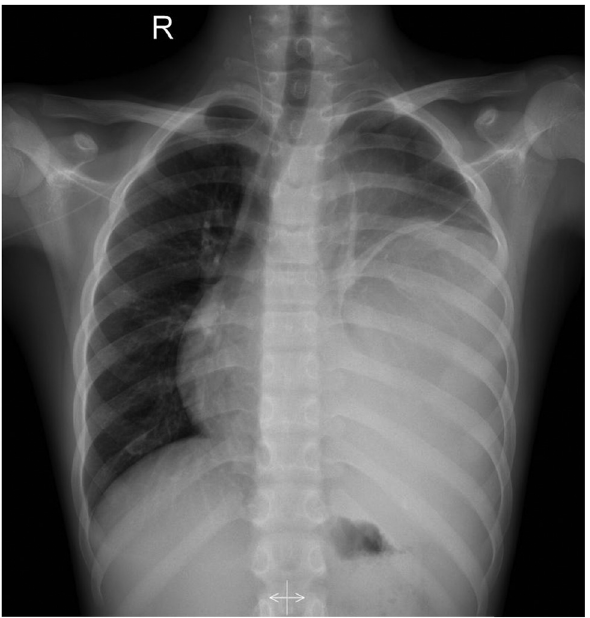
Figure 1: The chest X - ray showed a large dense shadow with an unclear boundary in the left lung fi eld, and the heart was obviously compressed and shifted to the